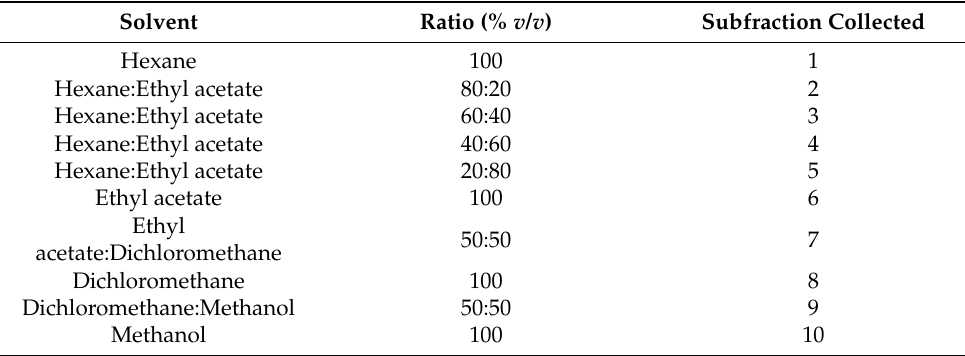
Table 6. Gradient solvent system used in column